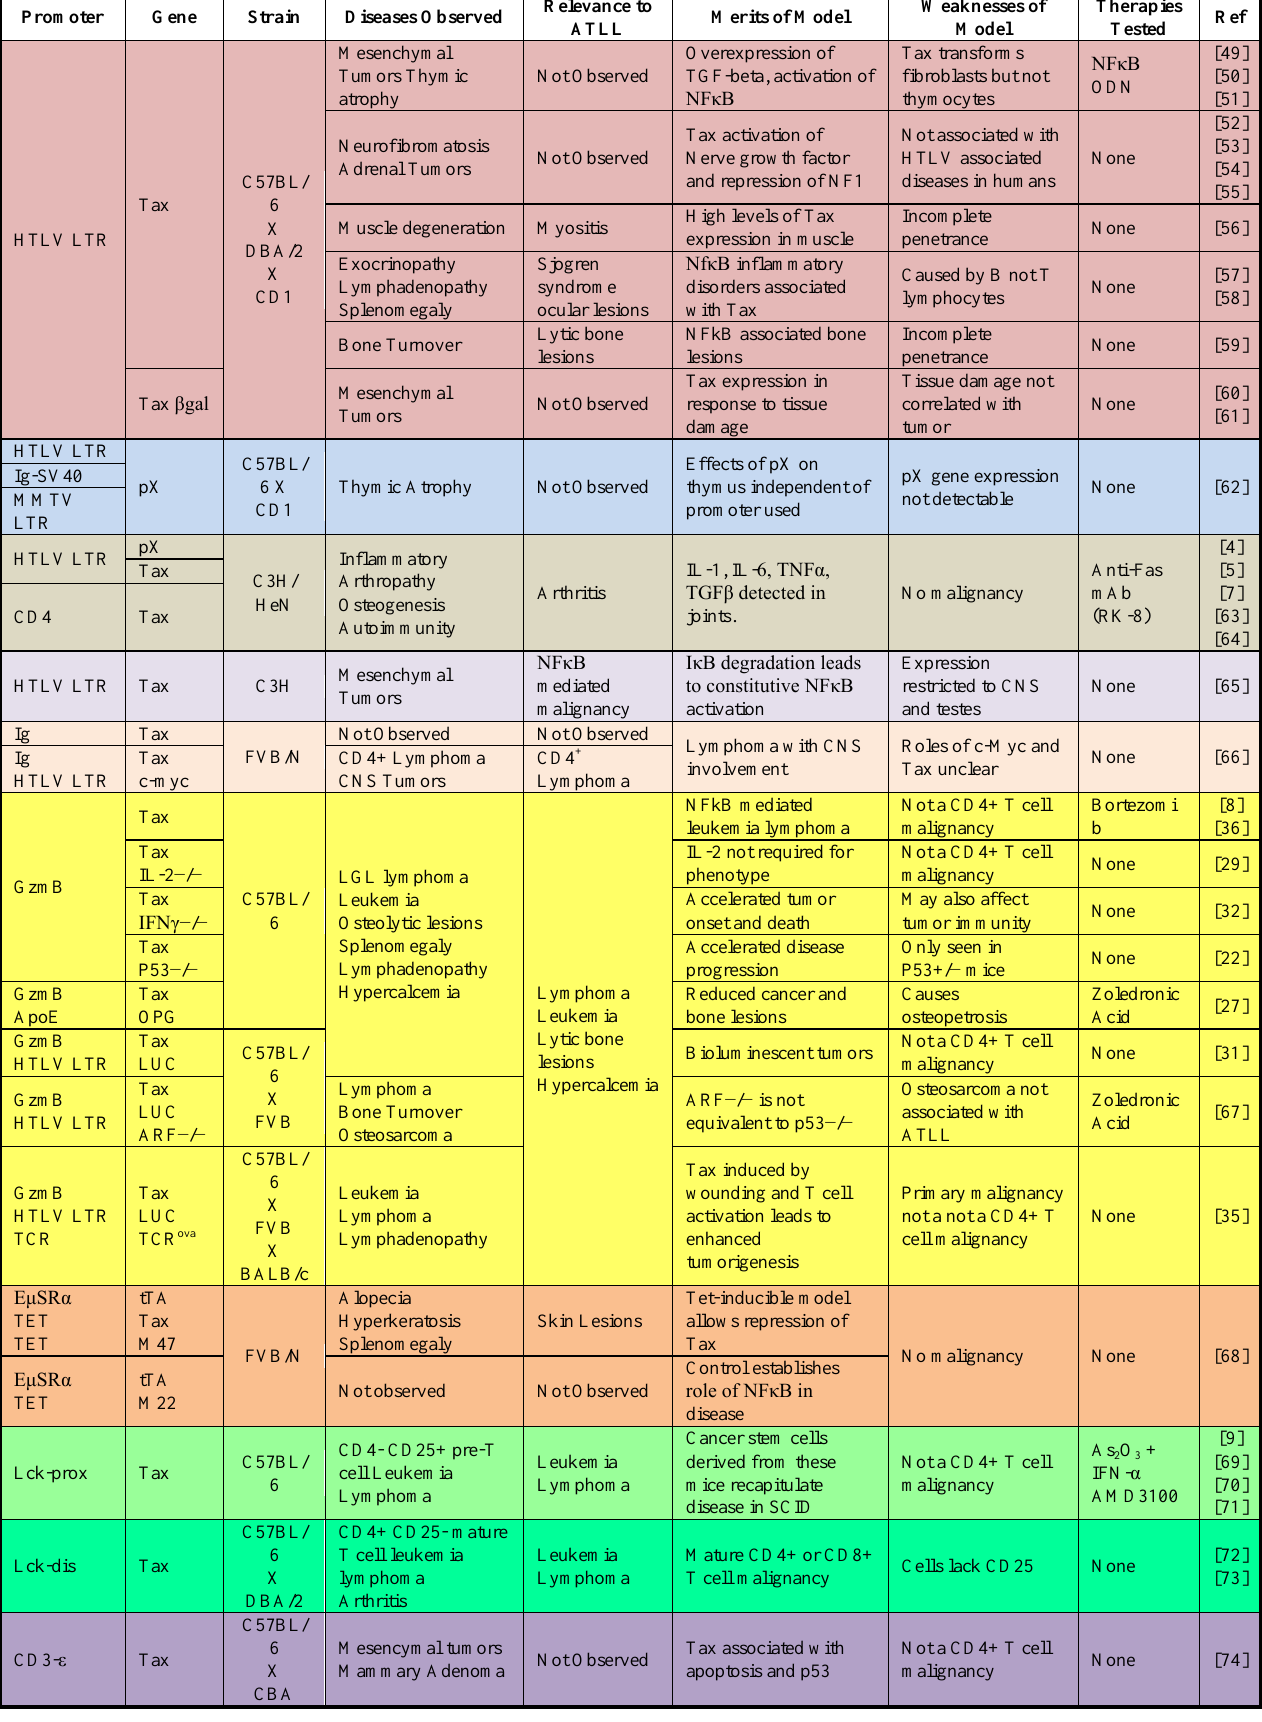
Table 1. Summary of tax transgenic mouse models of adult T-cell leukemia/lymphoma (ATLL).